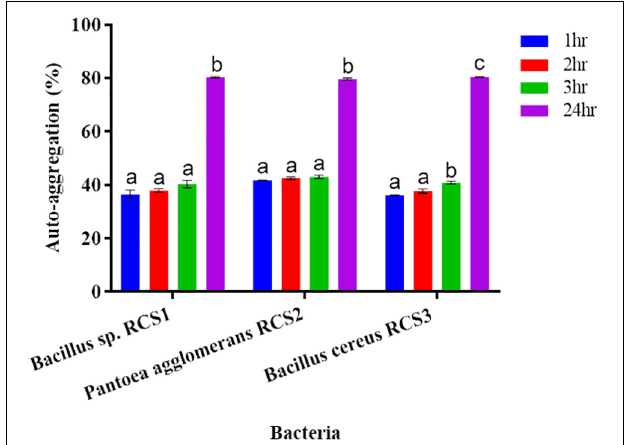
FIGURE 7 | Bacteria growths at different pH (1.0–10.0) levels. Values are shown as mean ± SE. Different letters (a, b, c, d, e, f, g, h, i, and j) indicate significant differences ( P <